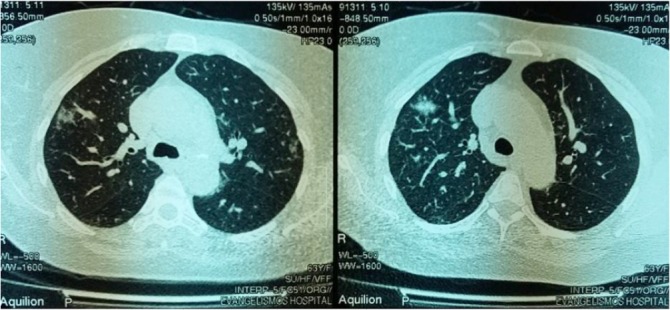
Chest CT scan showing a compact spindle – shaped mass in the right lower lobe surrounded by focal infiltration